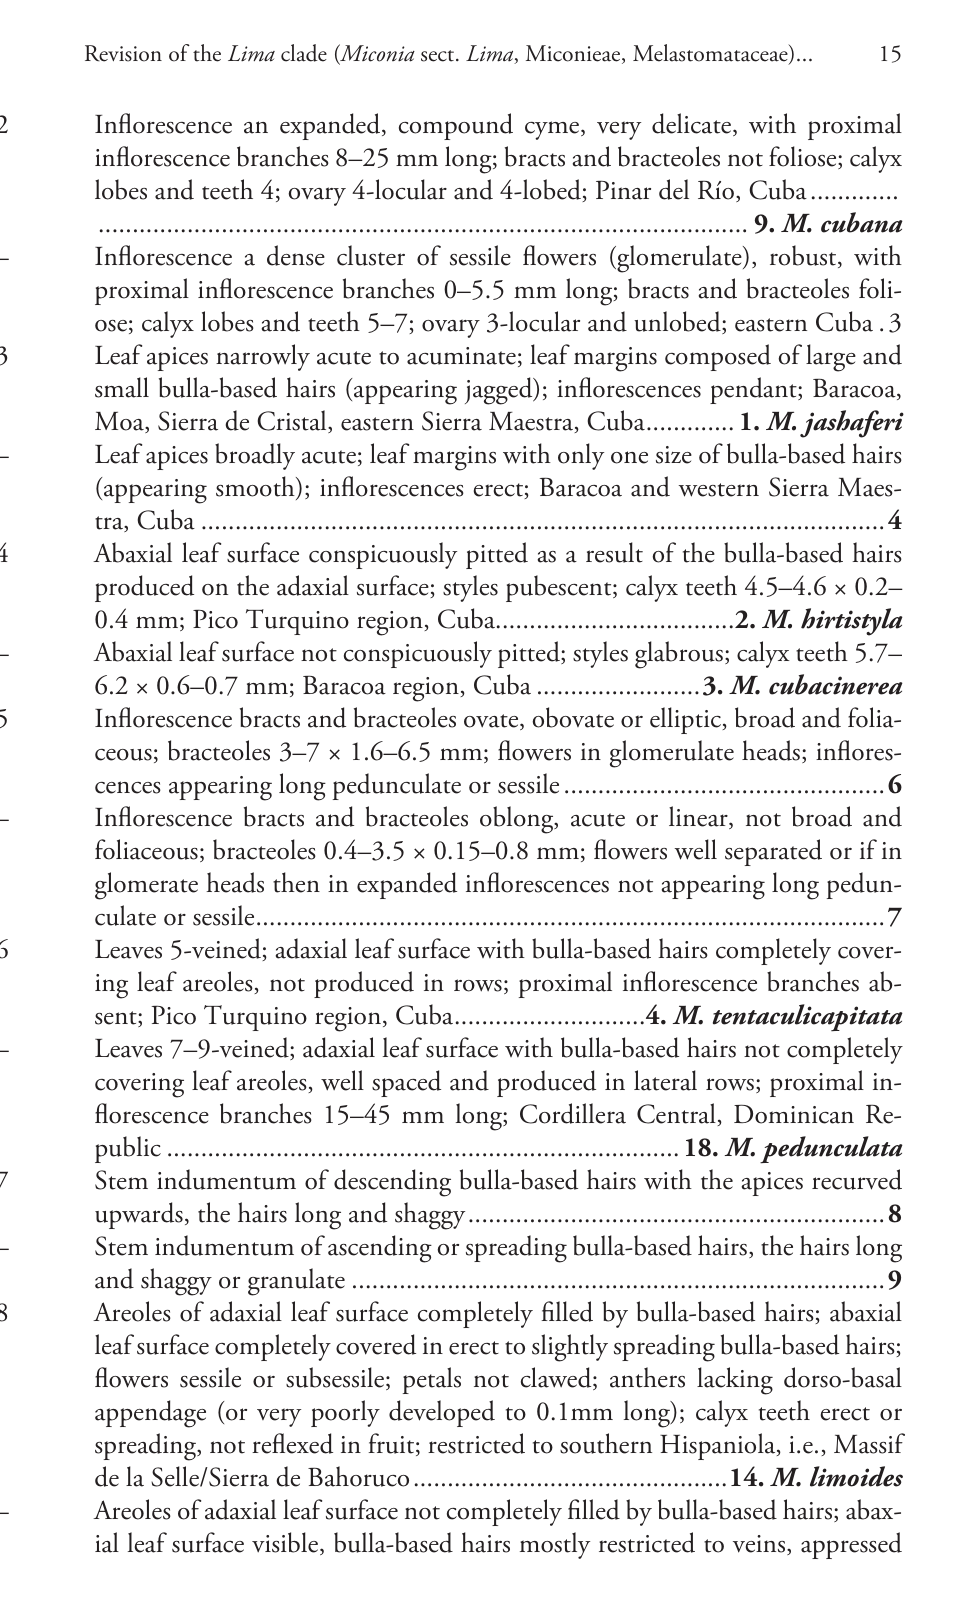
Inflorescence an expanded, compound cyme, very delicate, with proximal inflorescence branches 8–25 mm long; bracts and bracteoles not foliose; calyx lobes and teeth 4; ovary 4-locular and 4-lobed; Pinar del Río, Cuba ............. – Inflorescence a dense cluster of sessile flowers (glomerulate), robust, with proximal inflorescence branches 0–5.5 mm long; bracts and bracteoles foli- ose; calyx lobes and teeth 5–7; ovary 3-locular and unlobed; eastern Cuba .3 3 Leaf apices narrowly acute to acuminate; leaf margins composed of large and small bulla-based hairs (appearing jagged); inflorescences pendant; Baracoa, Moa, Sierra de Cristal, eastern Sierra Maestra, Cuba ............. 1. M. jashaferi – Leaf apices broadly acute; leaf margins with only one size of bulla-based hairs (appearing smooth); inflorescences erect; Baracoa and western Sierra Maes- tra, Cuba .................................................................................................... 4 4 Abaxial leaf surface conspicuously pitted as a result of the bulla-based hairs produced on the adaxial surface; styles pubescent; calyx teeth 4.5–4.6 × 0.2– 0.4 mm; Pico Turquino region, Cuba ................................... 2. M. hirtistyla – Abaxial leaf surface not conspicuously pitted; styles glabrous; calyx teeth 5.7– 6.2 × 0.6–0.7 mm; Baracoa region, Cuba ........................ 3. M. cubacinerea 5 Inflorescence bracts and bracteoles ovate, obovate or elliptic, broad and folia- ceous; bracteoles 3–7 × 1.6–6.5 mm; flowers in glomerulate heads; inflores- cences appearing long pedunculate or sessile ............................................... 6 – Inflorescence bracts and bracteoles oblong, acute or linear, not broad and foliaceous; bracteoles 0.4–3.5 × 0.15–0.8 mm; flowers well separated or if in glomerate heads then in expanded inflorescences not appearing long pedun- culate or sessile ............................................................................................ 7 6 Leaves 5-veined; adaxial leaf surface with bulla-based hairs completely cover- ing leaf areoles, not produced in rows; proximal inflorescence branches ab- sent; Pico Turquino region, Cuba ............................ 4. M. tentaculicapitata – Leaves 7–9-veined; adaxial leaf surface with bulla-based hairs not completely covering leaf areoles, well spaced and produced in lateral rows; proximal in- florescence branches 15–45 mm long; Cordillera Central, Dominican Re- public ........................................................................... 18. M. pedunculata 7 Stem indumentum of descending bulla-based hairs with the apices recurved upwards, the hairs long and shaggy ............................................................. 8 – Stem indumentum of ascending or spreading bulla-based hairs, the hairs long and shaggy or granulate .............................................................................. 9 8 Areoles of adaxial leaf surface completely filled by bulla-based hairs; abaxial leaf surface completely covered in erect to slightly spreading bulla-based hairs; flowers sessile or subsessile; petals not clawed; anthers lacking dorso-basal appendage (or very poorly developed to 0.1mm long); calyx teeth erect or spreading, not reflexed in fruit; restricted to southern Hispaniola, i.e., Massif de la Selle/Sierra de Bahoruco .............................................. 14. M. limoides – Areoles of adaxial leaf surface not completely filled by bulla-based hairs; abax- ial leaf surface visible, bulla-based hairs mostly restricted to veins,